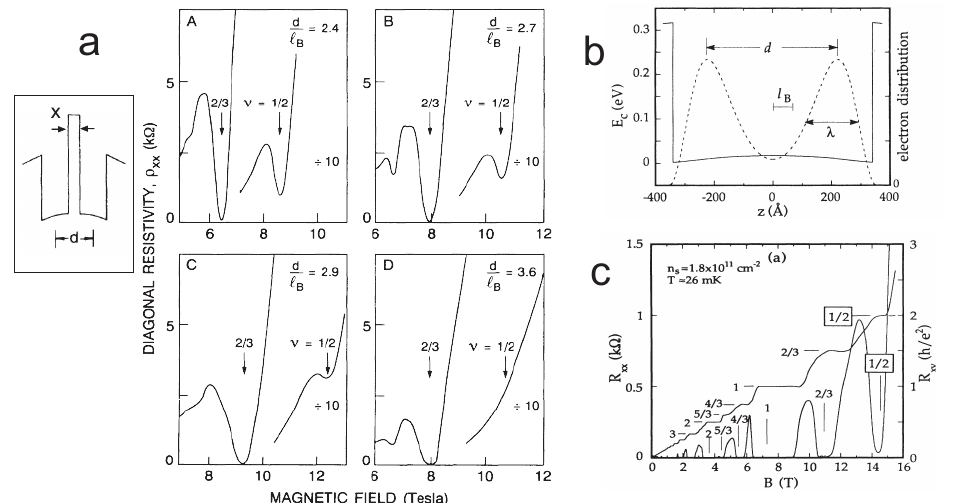
Figure 2. Astonishing observations of FQHE at 1/2 in bilayer GaAs 2DES. ( a ) Observation of ν = 1/2 FQHE state in double well GaAs/GaAlAs/GaAs (left inset) which is dependent on the width of the barrier x as listed in Table 3, after [45]. ( c ) The similar observation of FQHE at 1/2 in bilayer Hall structure in wider well in GaAs heterostructure with transverse profile of the electron density shown in ( b ) (the profile of the well with width 68 nm used in [44] to separate electron Hall layers—solid line indicates the well conduction band, dashed line shows electron distribution for n = 1.8 × 10 11 /cm 2 , d = 44.5 nm, the magnetic length l B is marked for B = 15 T at which the state ν = 1 state at 1/2 disappears when the well is too wide resulting in the inter-layer barrier growth, after [44]. Table 3. The collection of the parameters for the double well shown in the inset in Figure 2, x is the barrier thickness, d is the well center-to-center distance, for A − C d equals to 21.1 nm and for D to (cid:113) ¯ h 27.9 nm, l B = , both quantum well widths are 18 nm (after eB